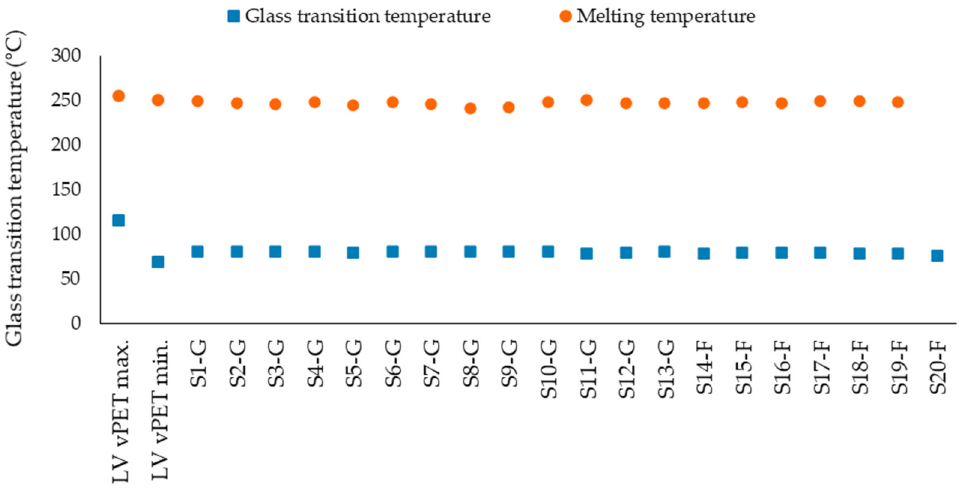
Figure 4. Thermal properties of rPET samples in comparison with literature values for vPET.